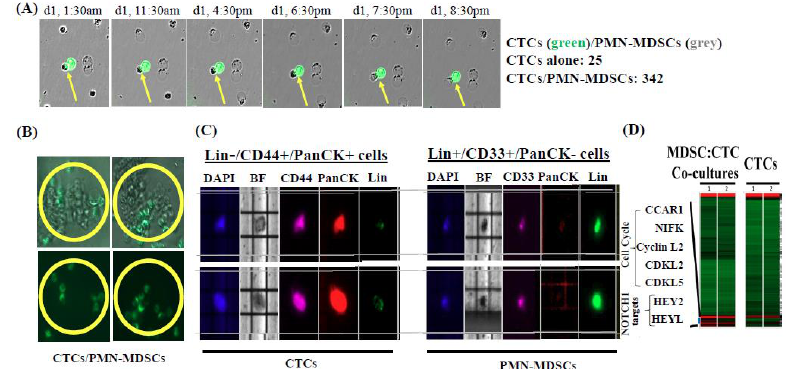
Figure 6. Patient-isolated PMN-MDSCs interact with and promote CTC proliferation. ( A ) CTCs and PMN-MDSCs isolated from blood of BCBM patients were co-cultured over time and their growth was monitored by IncuCyte ® S3 Live-Cell Analysis System. Snap-shots were taken at indicated times using IncuCyte ® real-time videomicroscopy. Yellow arrows point out to specific CTC/PMN-MDSC interactions. ( B ) Heterotypic clusters formation between CTCs and PMN-MDSCs detected over time (>72 h) by IncuCyte ® following CTC/PMN-MDSC co-culturing. CTCs were labeled green using Vybrant™ DiO cell-labeling solution (Molecular Probes, Inc., Eugene, OR, USA), and clusters were visualized (yellow circles) and analyzed for CTCs and PMN-MDSCs presence. A >10-fold multiplication of CTC numbers could be detected when clustered with PMN-MDSCs. ( C ) CTC/PMN-MDSC clusters were retrieved from co-cultures employing CellCelector TM (ALS, Inc., Jena, Germany), dissociated into single-cell suspensions, stained for specific markers, and analyzed by the DEPArray. Representative images of single CTCs and PMN-MDSCs from the same patient are shown. BF = Brightfield image. ( D ) Transcriptomic analyses of CTCs retrieved from CTC/PMN-MDSC clusters following co-cultures vs. CTCs alone. Highest expression of genes related to cell cycle progression and Notch1 targets are shown. Dissociated cells from CTC/PMN-MDSC clusters were collected directly into a pre-chilled tube maintained at 4 °C containing RNA lysis buffer. Total RNA was collected according to the manufacturer’s protocol (Macherey-Nagel, Inc., Düren, Germany). Subsequently, RNA and cDNA amplifications, quality controls and gene expression arrays were performed at the Sequencing and Non-coding RNA Program Core (MD Anderson Cancer Center, Houston, TX, USA) using the HTA 2.0 gene chip (Affymetrix, Inc., Santa Clara, CA, USA). Subsequent